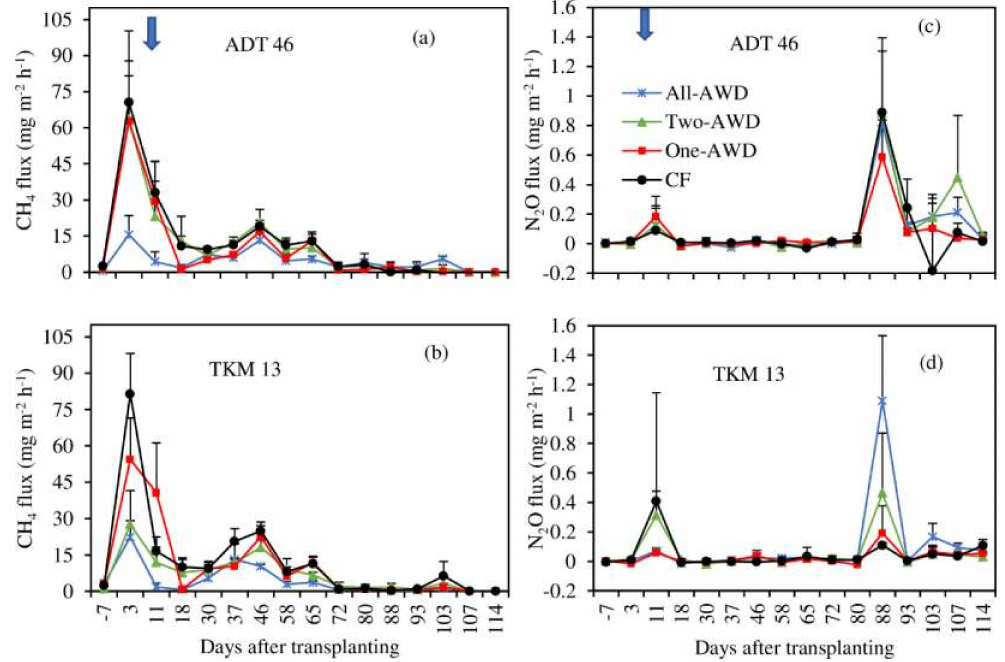
Figure 4. Variation in CH 4 ( a , b ) and N 2 O ( c , d ) fluxes during wet season rice for different water management practices. Error bars indicate standard error of means ( n = 3). Arrow—start AWD irrigation. Full-AWD—wetting and drying cycles throughout the growing season, Two-AWD—two early drying periods, One-AWD—one early drying period, CF—continuous